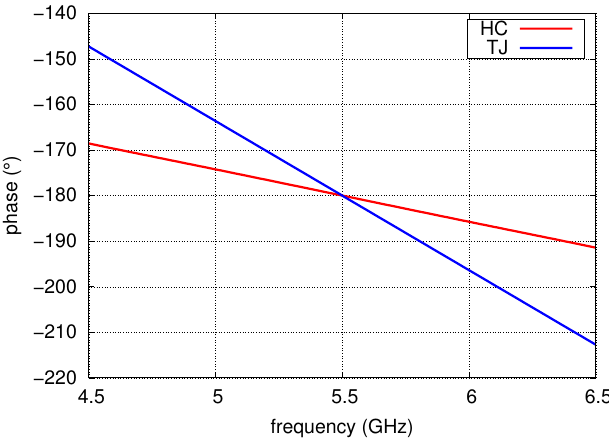
Figure 8. Phase shift for TJ and HC networks.